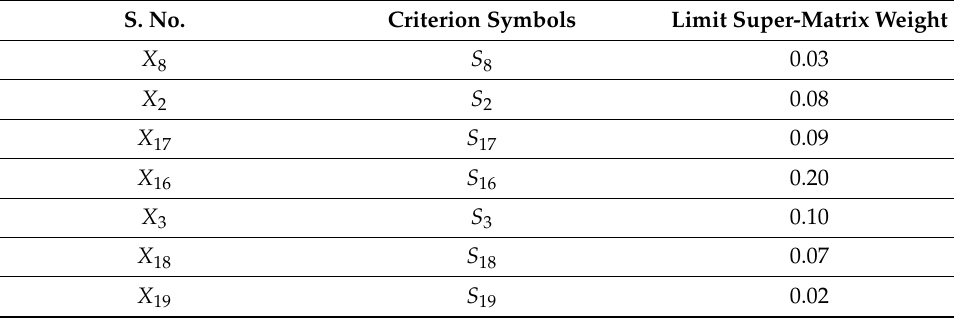
Table 9. Weights of the switches for the controller placement in cluster 6 (blue). S. No.